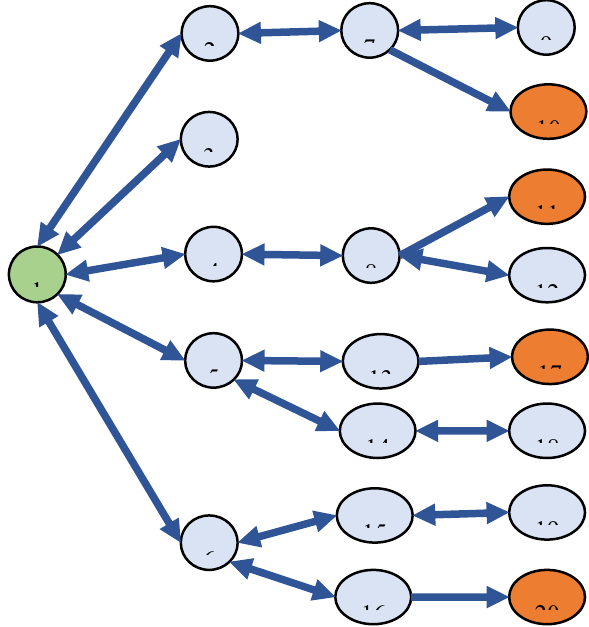
Figure 8. MDP with initial state in green and terminal states in red Actions are either assemble oval or squared flange if the arrow points to the right. If the arrow points to the left, disassembly action is selected. Sometime the same action could lead to different solutions. The ‘assemble flange’ from S7 leads to S10 corresponding to the cor– rect mount in slot 3 and to S9 corresponding to a wrong position (slot 2). In this case a small statistical pro– take into account the possibility of a human